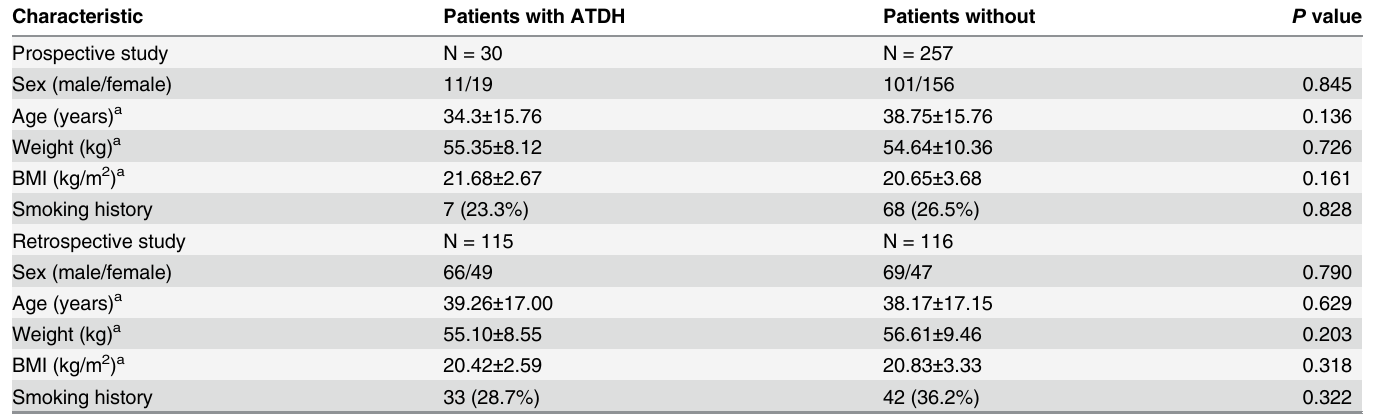
Table 1. Characteristics of patients with and without